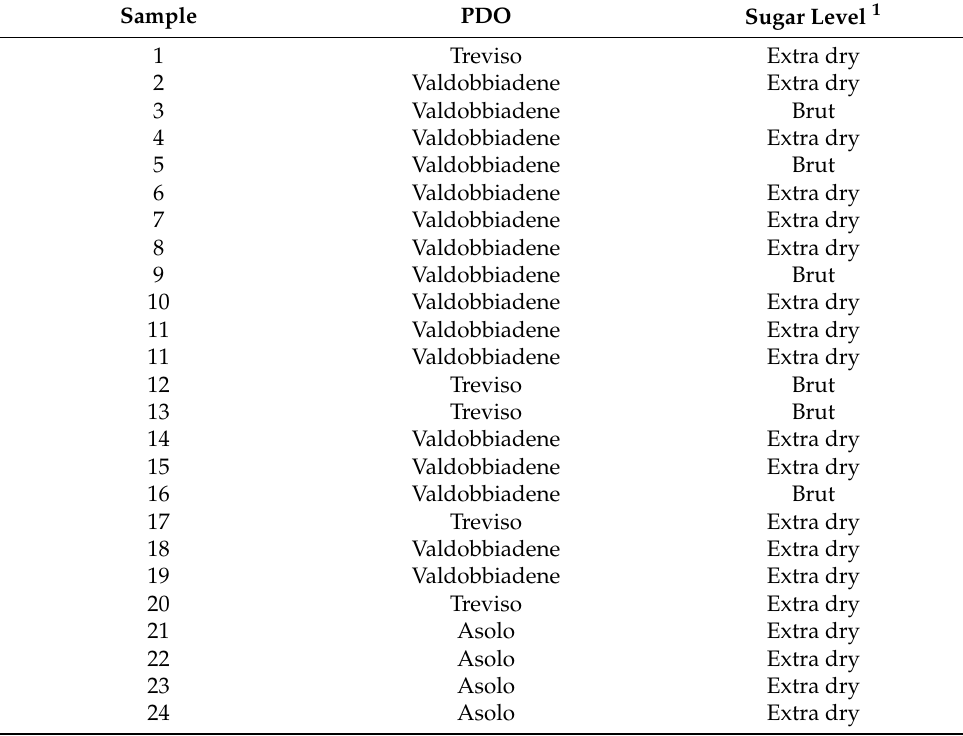
Table 1. Prosecco wine sample, appellation and sweetness